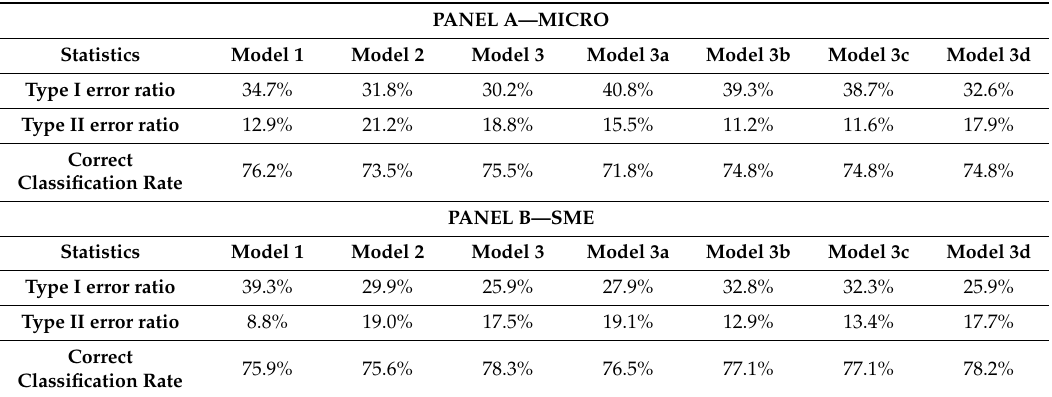
Table 7. Error Estimation.